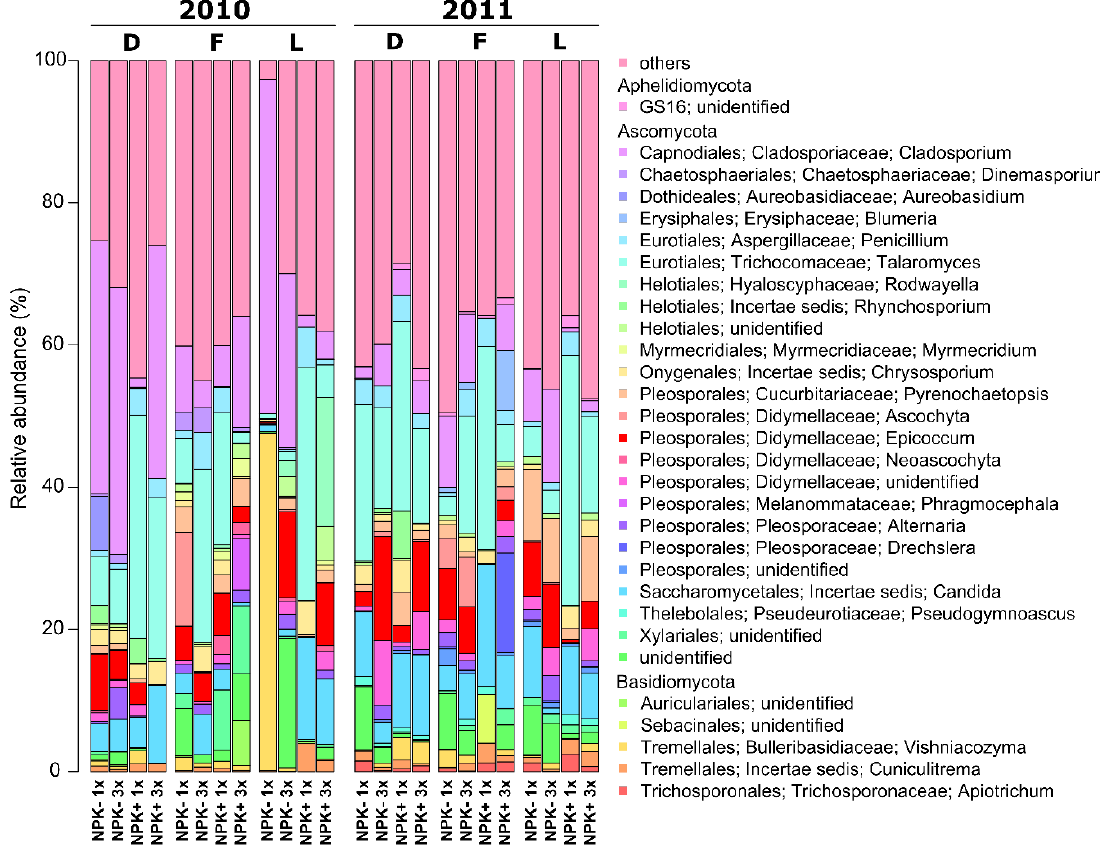
Figure 1. Fungal endophyte community composition at genus level. Fungal endophytes in aerial plant parts of D. glomerata (D), F. rubra (F) and L perenne (L) collected in September 2010 and 2011 were investigated. Three replicates per grass species and treatment were analysed with one exception: L. perenne samples were collected only on two non-fertilized plots mown once in 2010. One replicate comprised 10 plants. The relative abundances of the community composition were calculated for each sampling year separately. Only fungal genera with an average abundance >0.5% in the respective year are shown. Abbreviations: NPK-, no fertilizer application; NPK+, with fertilizer application; 1x, mown once a year; 3x, mown three times a year.